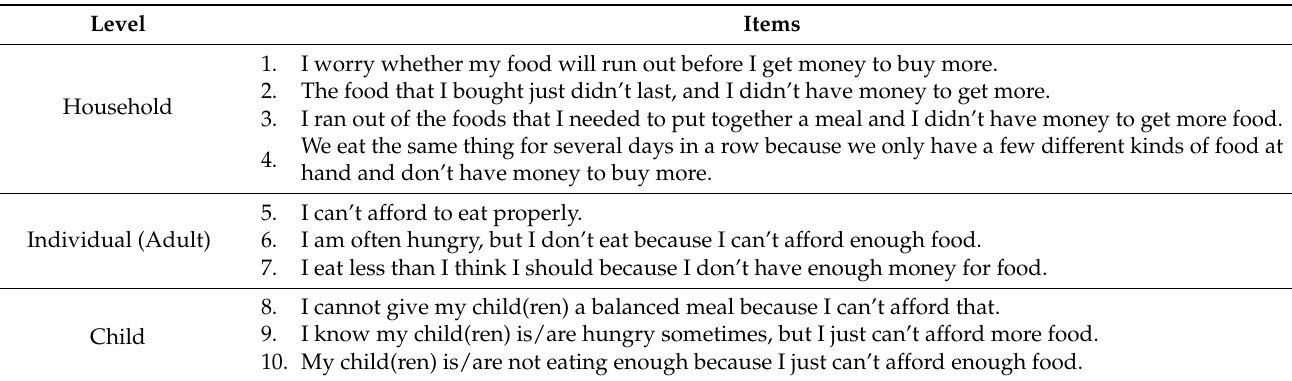
Table 1. The 10 items in the Radimer/Cornell hunger